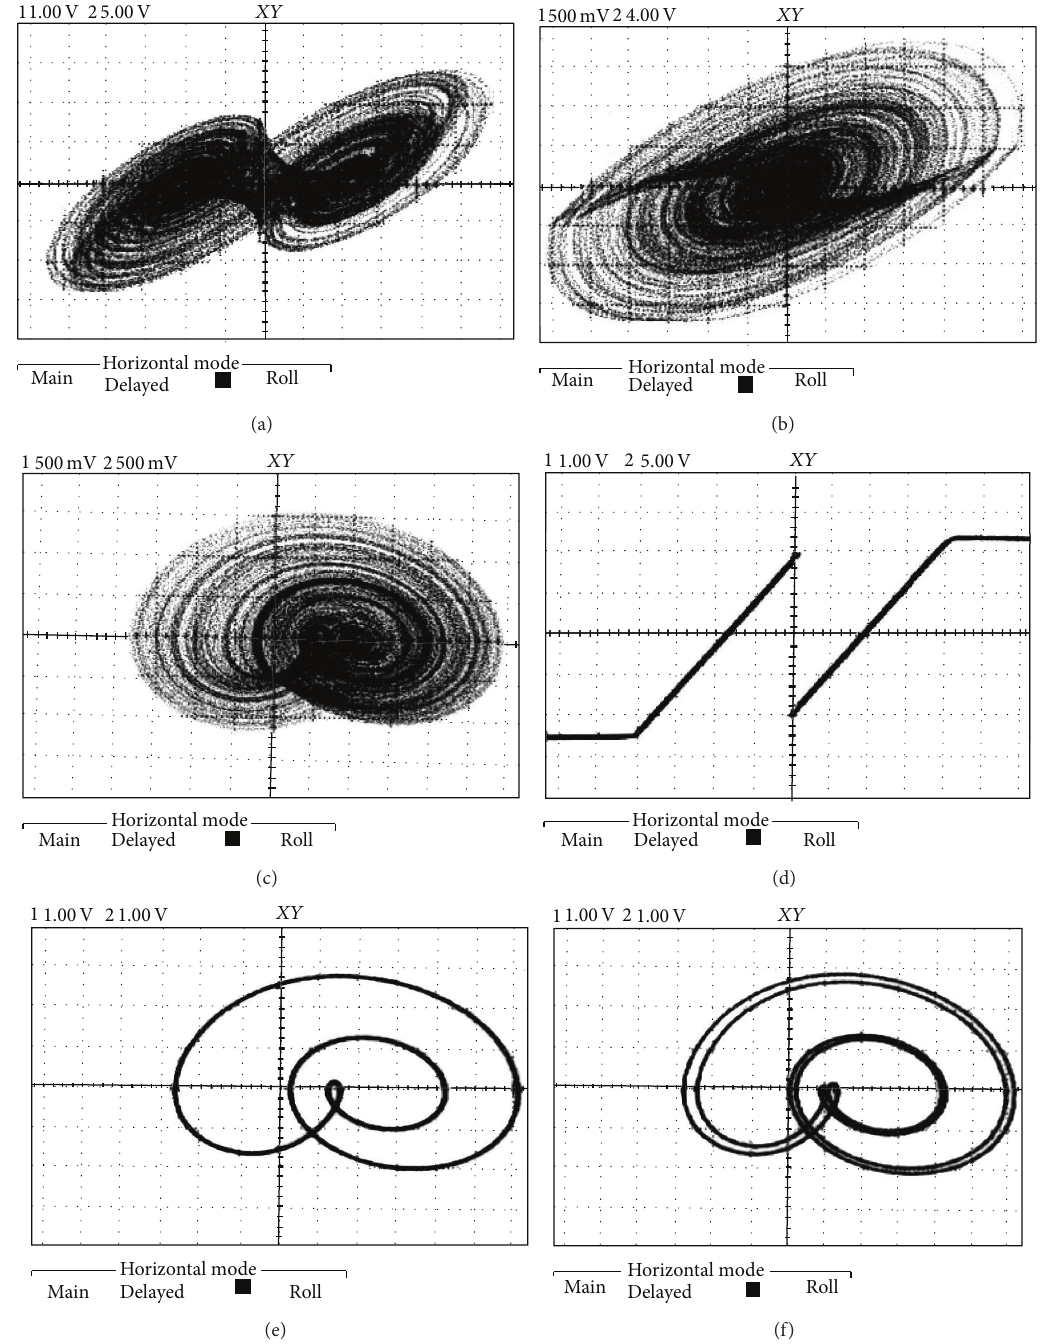
Figure 11: Several examples of the laboratory measurements (for case 𝐴 ): double-scroll attractor (a,b), single-scroll (c), AV curve of nonlinear resistor including saturation (d), limit cycle (e), and period doubling